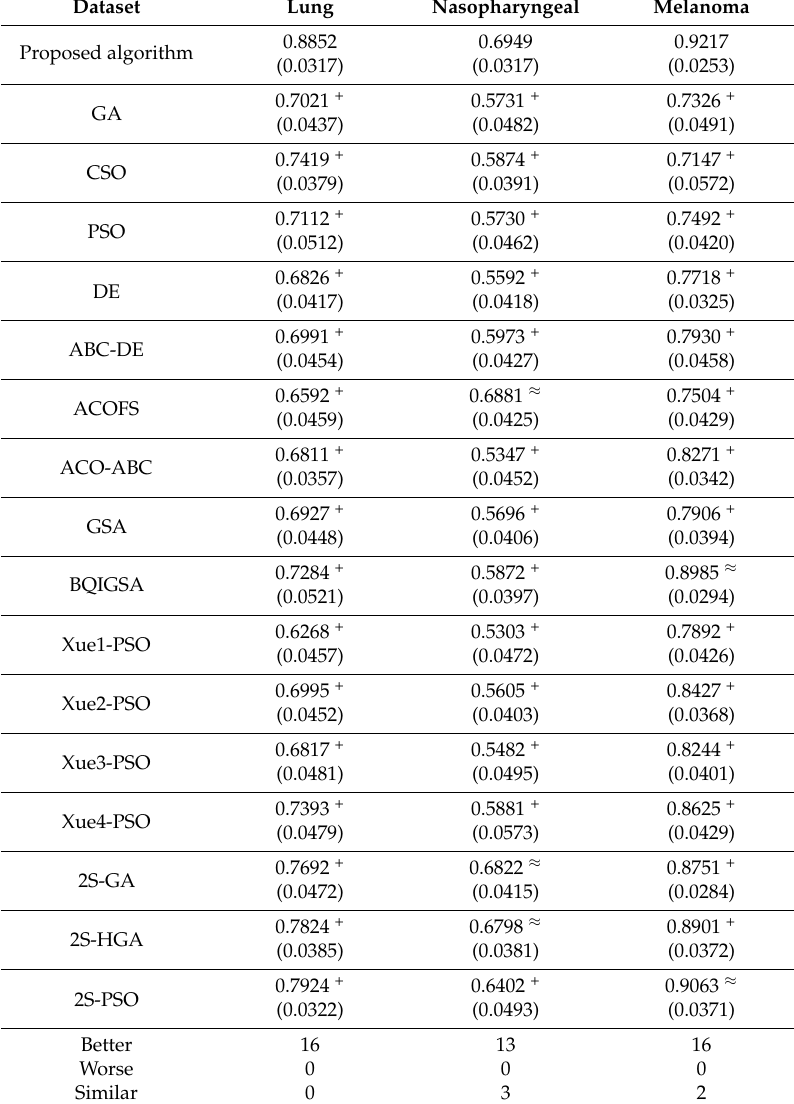
Table 3. Average positive predictive value of different algorithms in cancer